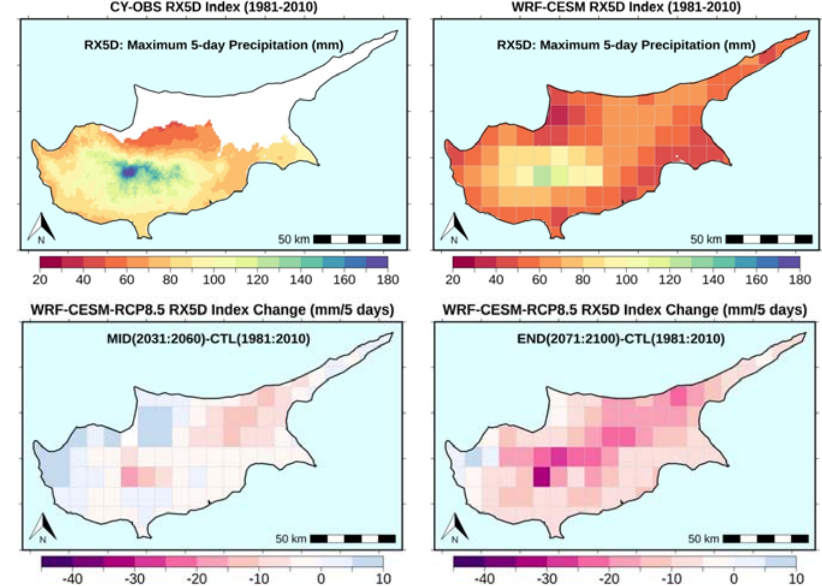
Figure 9. Observed ( top left ) and simulated ( top right ) maximum 5 ‐ day precipitation per year (RX5D) for the period 1981 to 2010 and projected changes for the middle ( bottom left ) and end of the 21st century ( bottom right ).